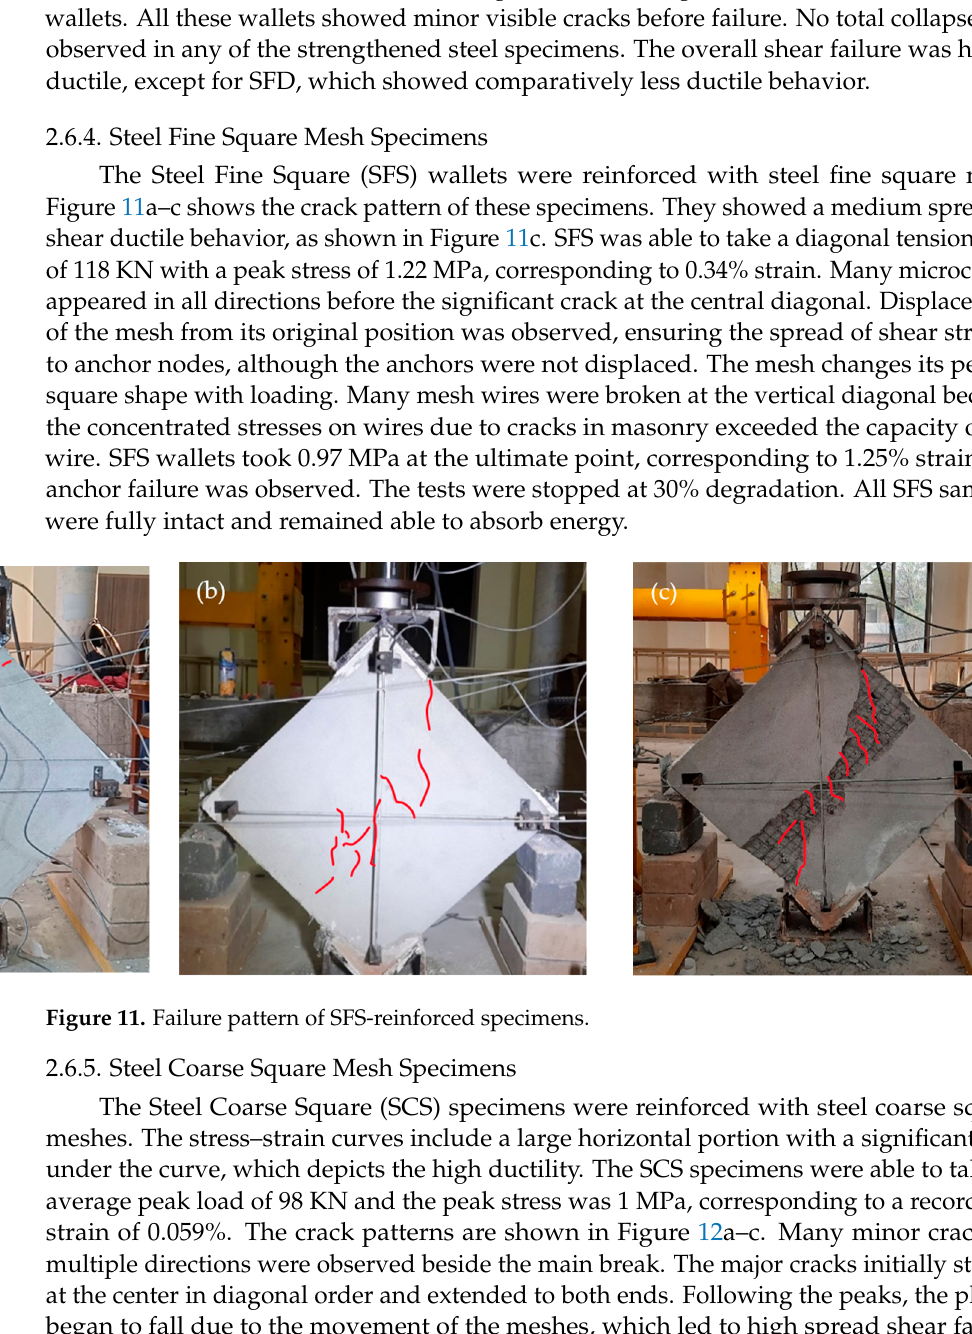
Figure 12. Failure pattern of SCS-reinforced specimens. 2.6.6. Steel Fine Diagonal Mesh Specimens The Steel Fine Diagonal (SFD) specimens showed less ductile behavior compared to the SFS and SCS specimens, although they were able to take the highest load of all the wallets at 139 KN. The initial crack patterns are shown in Figure 13a–c. Breakage of the mesh wires was observed at the peak load, and the load capacity dropped suddenly. The peak stress was 1.4 MPa with a strain of 0.346%. Many of the mesh wires were already